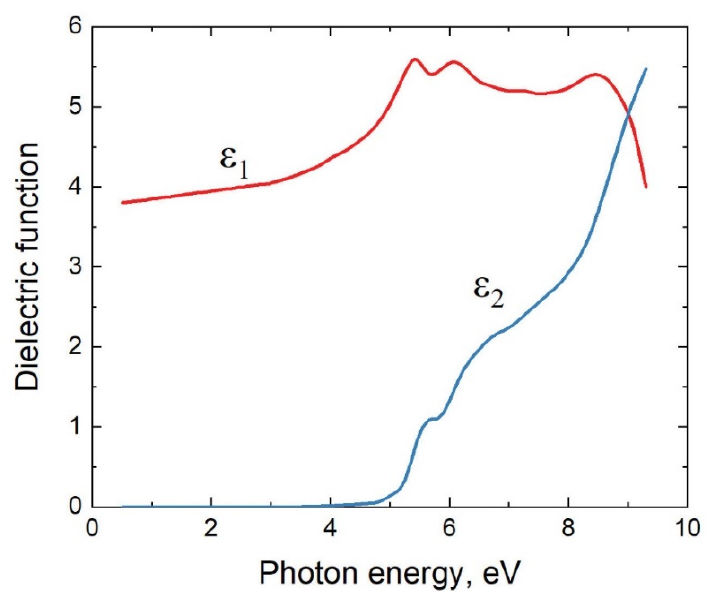
Figure 17. Dependence of the ordinary dielectric function of α -Ga 2 O 3 on the photon energy. ε 1 is the real part of the dielectric function, ε 2 is its imaginary